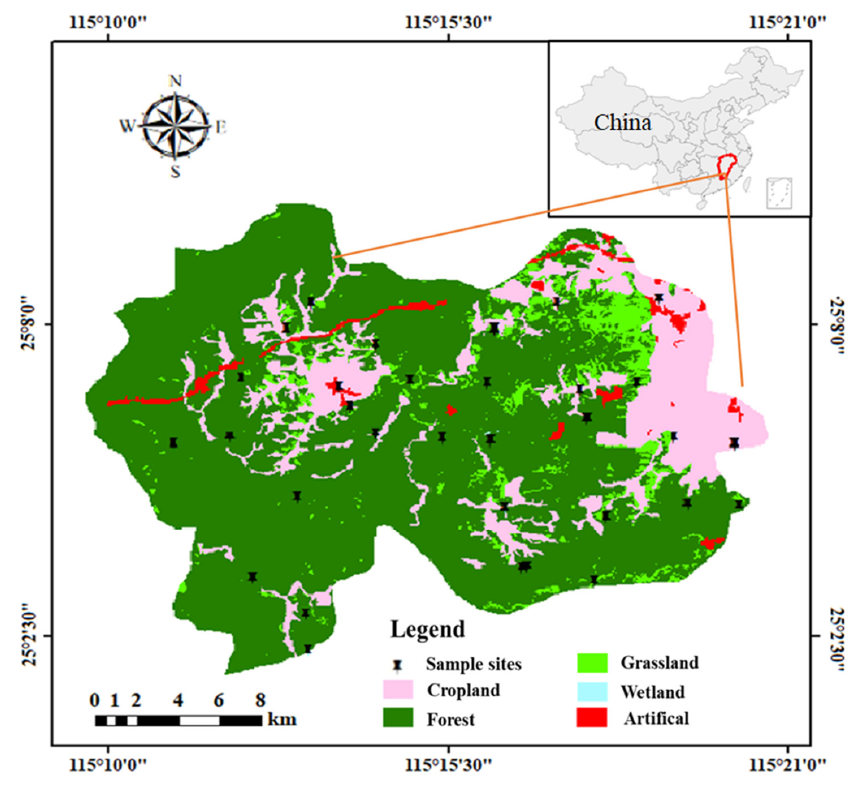
Figure 1. Location of the study area and sampling sites.